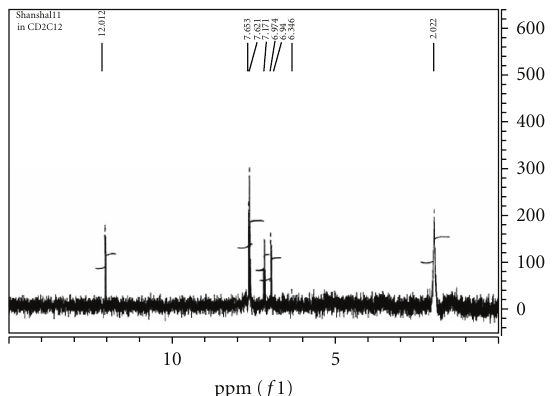
Figure 1: 1 HNMR Spectrum of SBH in CD 2 Cl 2 .